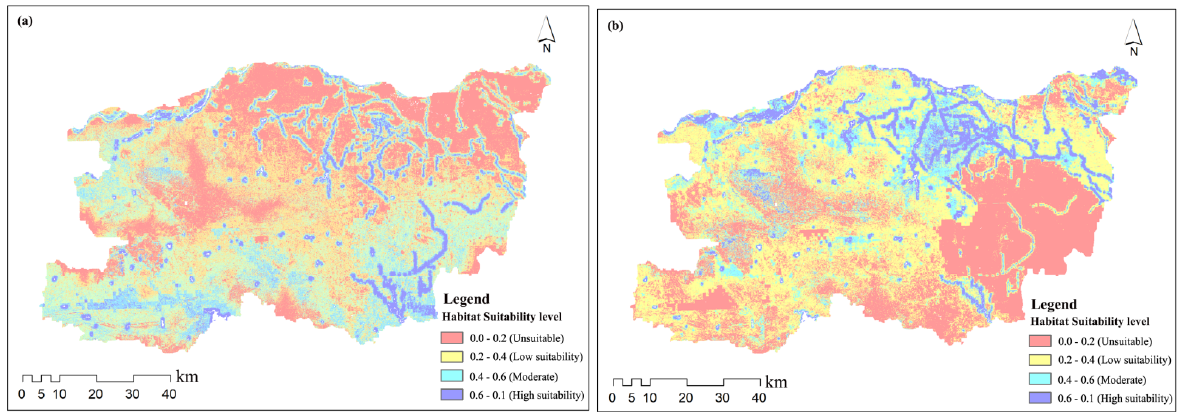
Figure 5. Classification of ( a ) the wetland plants and ( b ) waterfowl habitat suitability levels in Zhengzhou.